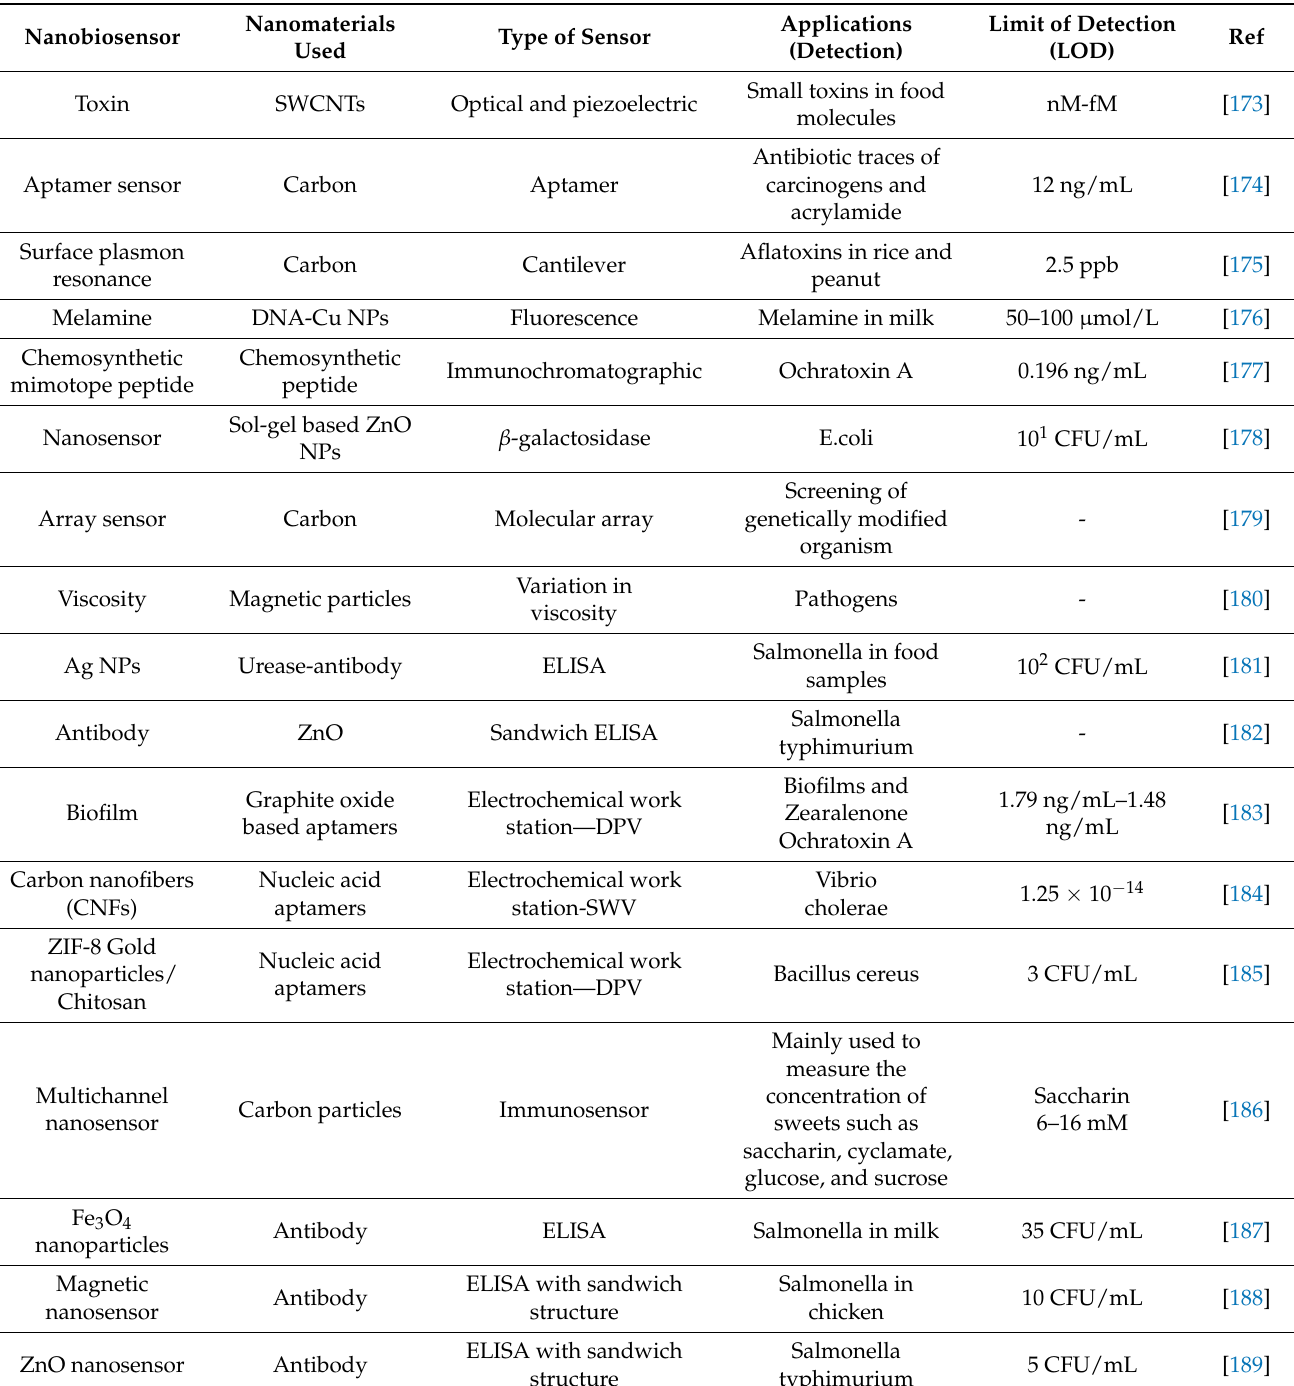
Table 9. Different types of nanobiosensors in the food